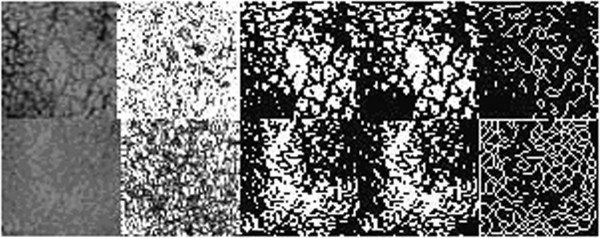
Trabeculae thread.